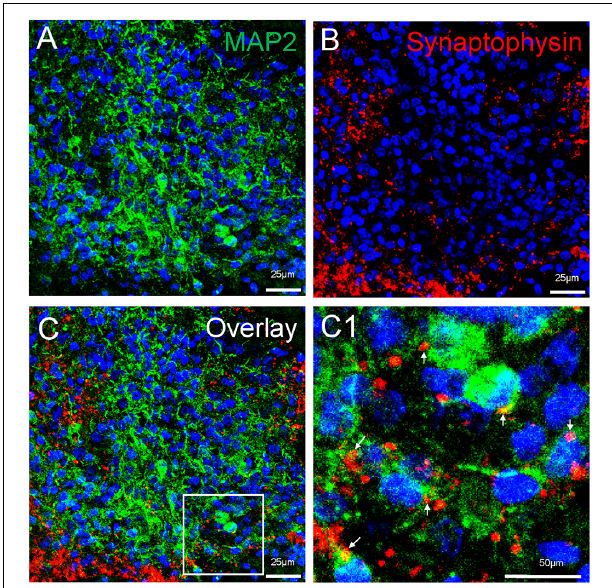
FIGURE 8 | Detection of synaptogenesis in MCOs. Multi-labeled immunofluorescent and confocal analysis shows evidence of neuritogenesis/ synaptogenesis and apoptosis in MCOs. (A,B) Enriched dendritic arborization with long process (MAP2 + ) and presynaptic axonal terminals (Synaptophysin + ), axon-dendritic synapse connections (arrows) were clearly visualized in all tested sections of MCOs. (C) represents the overlay image from (A) and (B) . Panel (C1) is digital zoom-in image of the inset in (C)